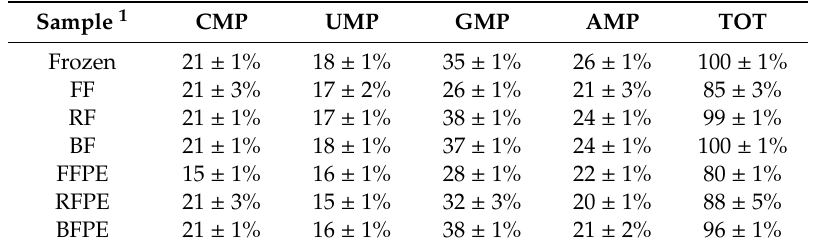
Table 4. Amount in percentage area of unmodified nucleotide monophosphates identified in the first set of samples as detected by chromatograms.